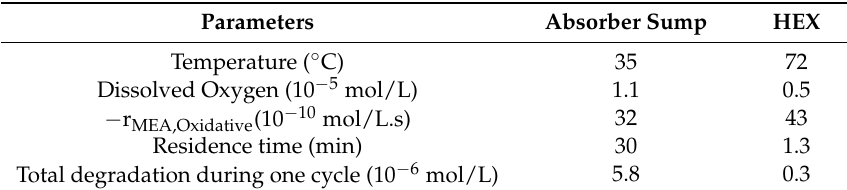
Table 2. Comparison of degradation rates in sump and HEX.